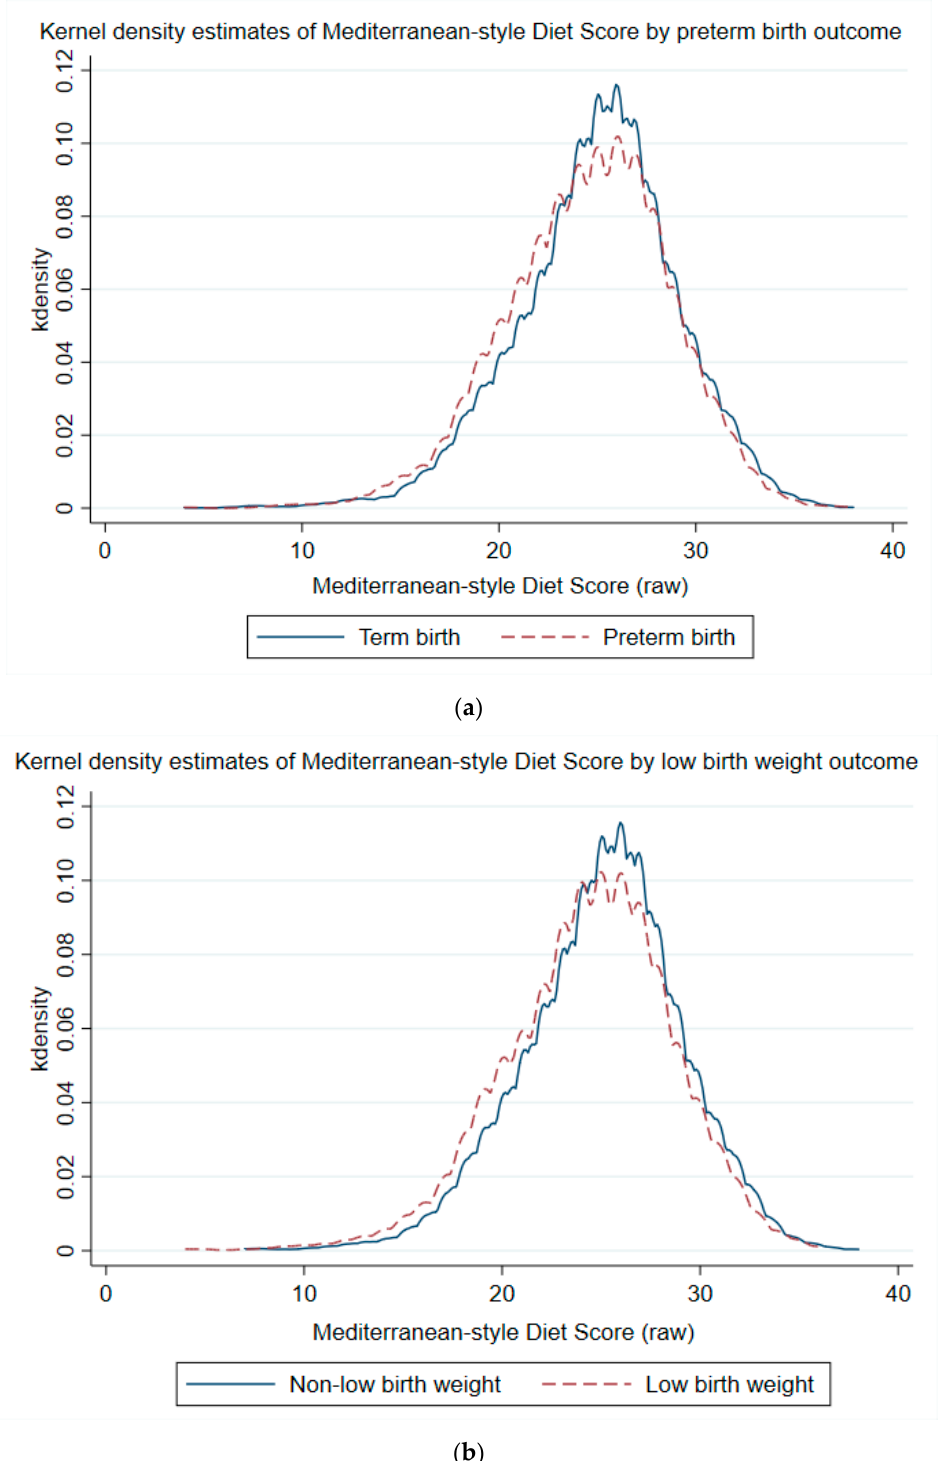
Figure 2. ( a ) Kernel density plots of Mediterranean-style diet score by birth outcomes. Shown are outcomes related to duration of pregnancy, with blue curve for term birth and red dashed curve for overall preterm birth. No adjustments were made for these plots. The x -axis represents the raw aggregate Mediterranean-style diet score. ( b ) Kernel density plots of Mediterranean-style diet score by birth outcomes. Shown are outcomes related to birth weight, with blue curve for non-low birth weight and red dashed curve for low birth weight. No adjustments were made for these plots. The x -axis represents the raw aggregate Mediterranean-style diet score.